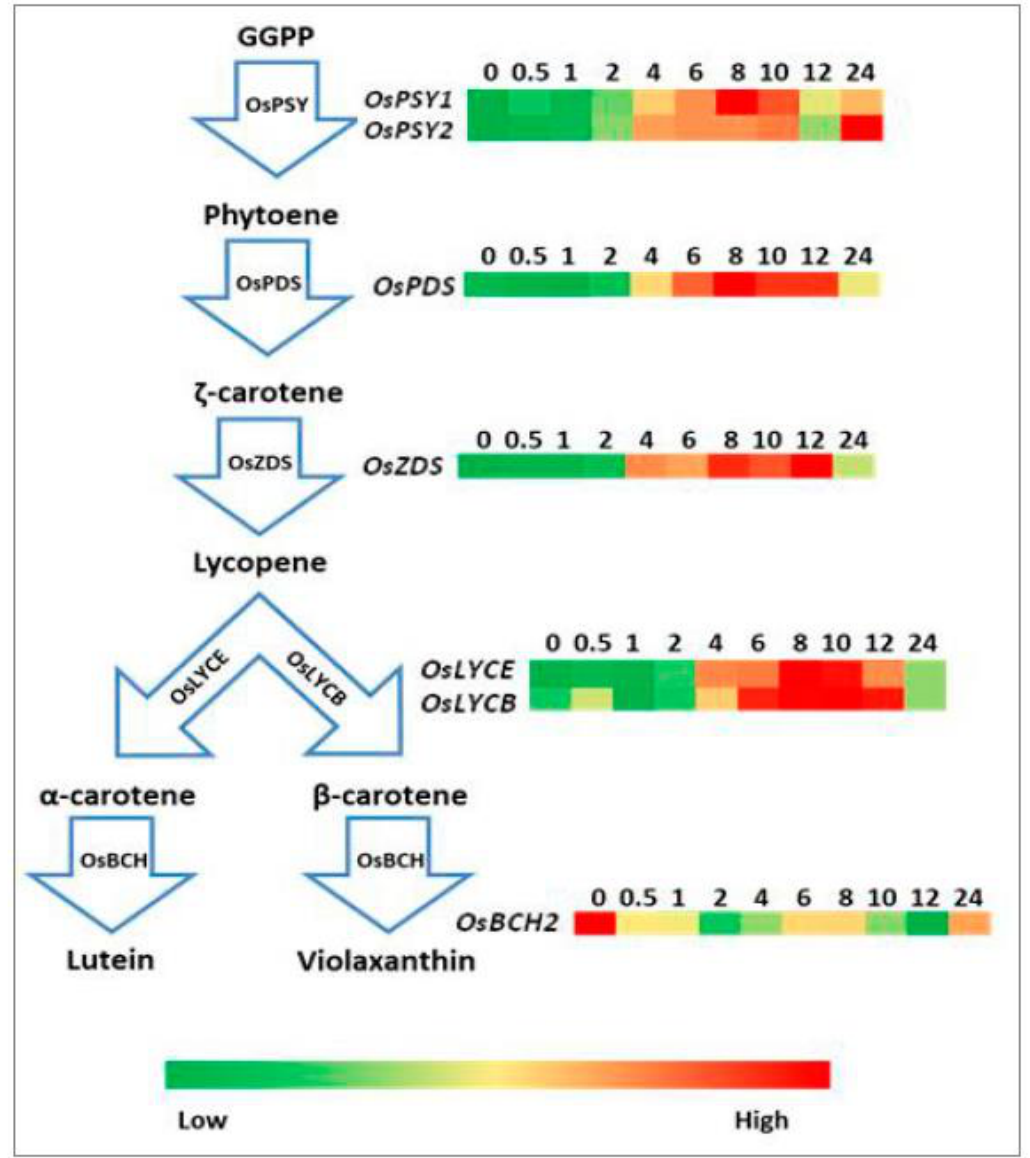
Figure 4. Relative expression levels of carotenoid pathway genes in etiolated rice leaves during de-etiolation at different times after the onset of irradiation with white light.